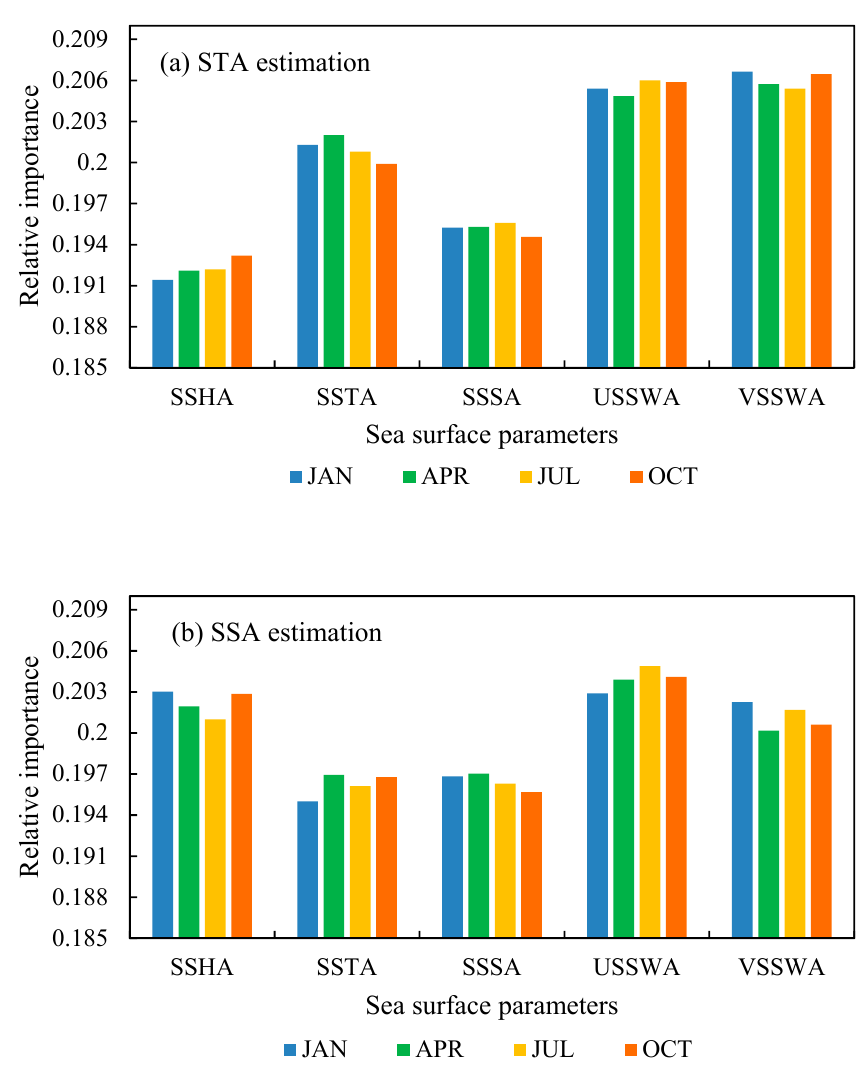
Figure 10. The relative importance of the five sea surface parameters (SSHA, SSTA, SSSA, USSWA, and VSSWA) for the XGBoost ( a ) STA and ( b ) SSA estimation model at 1000 m in January (blue), April (green), July (yellow), and October (orange).